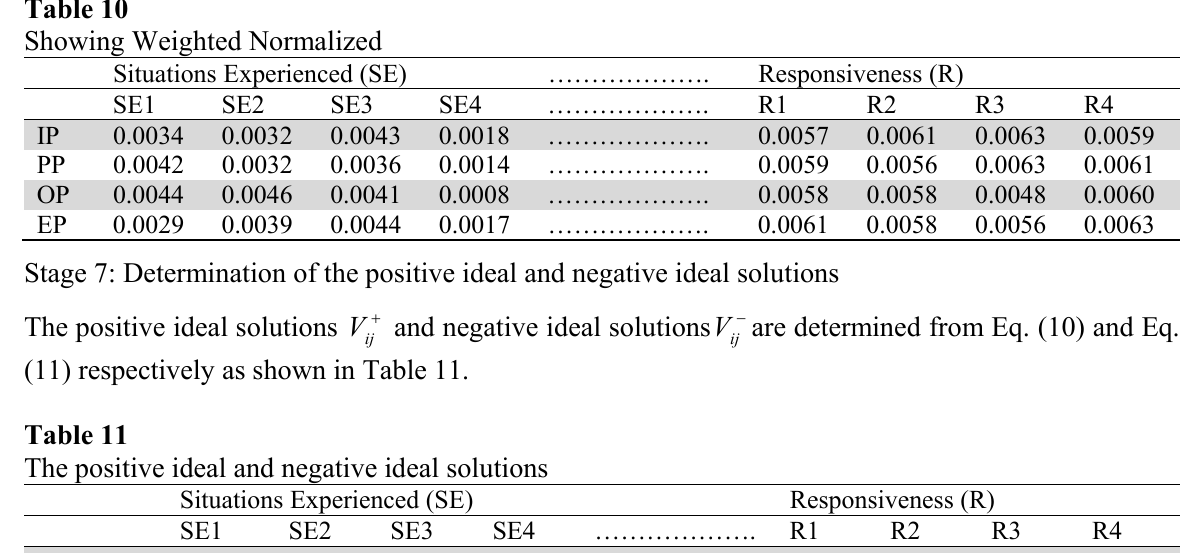
Stage 6: Weighted Normalized decision matrix